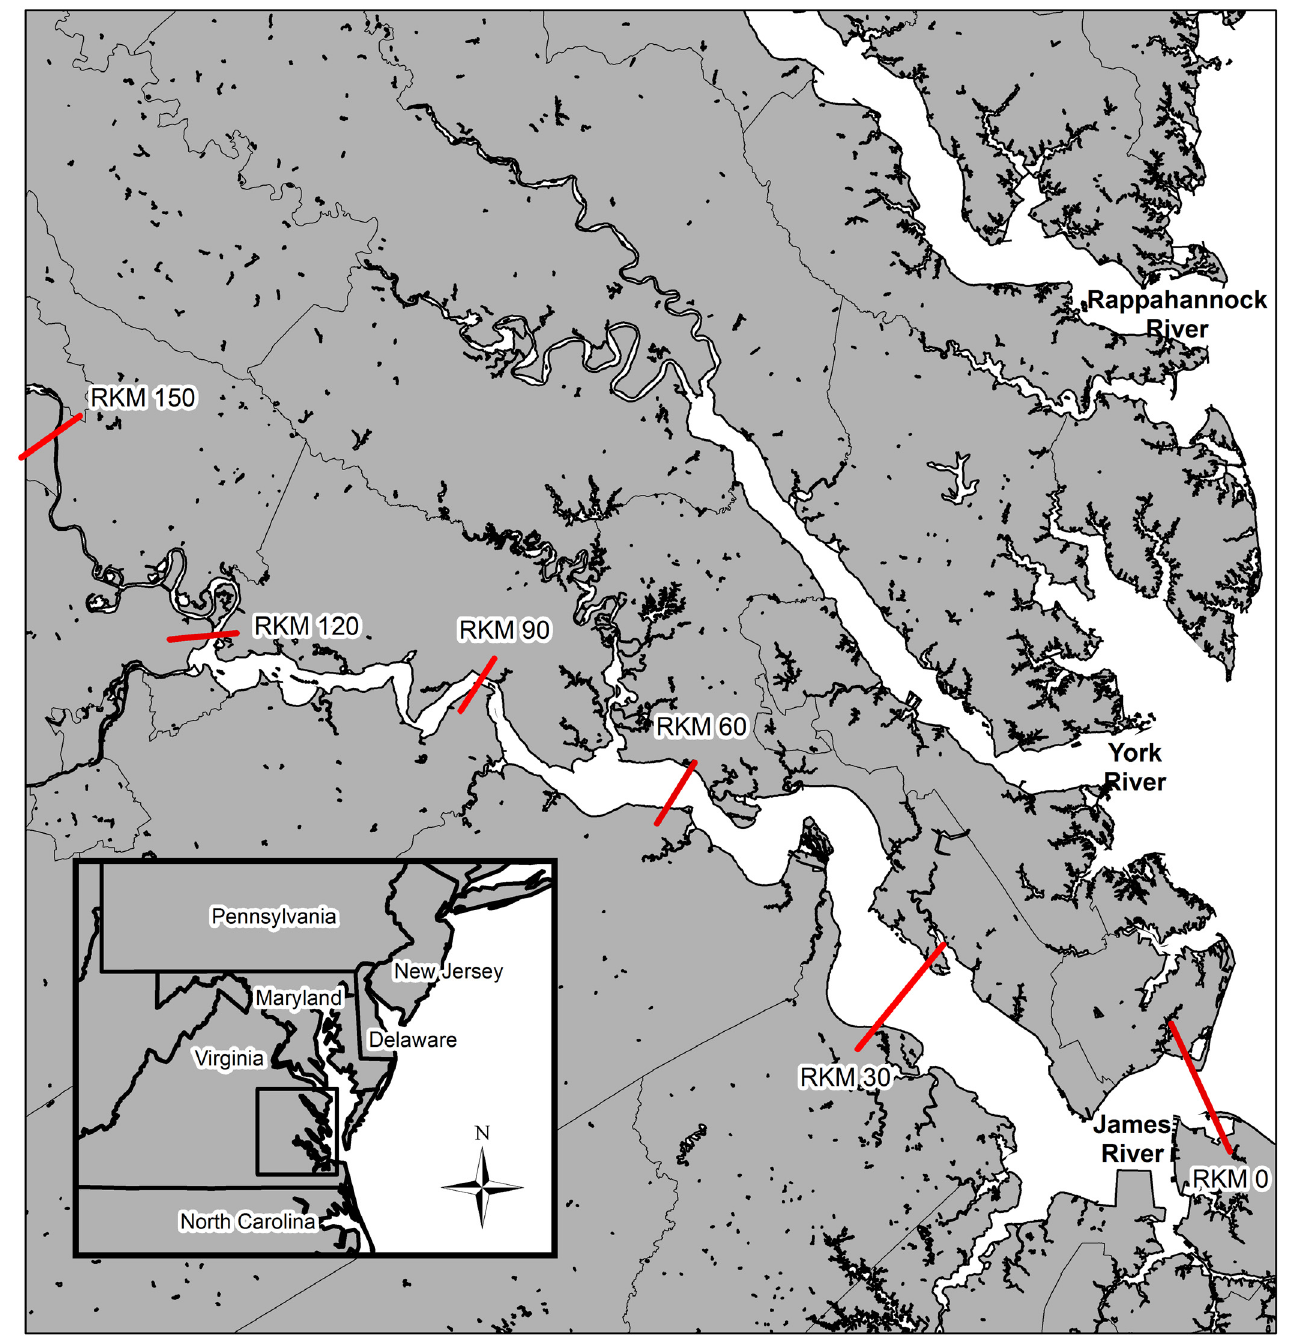
Fig 1. Map showing the tidal portion of the James River with river kilometer (rkm)